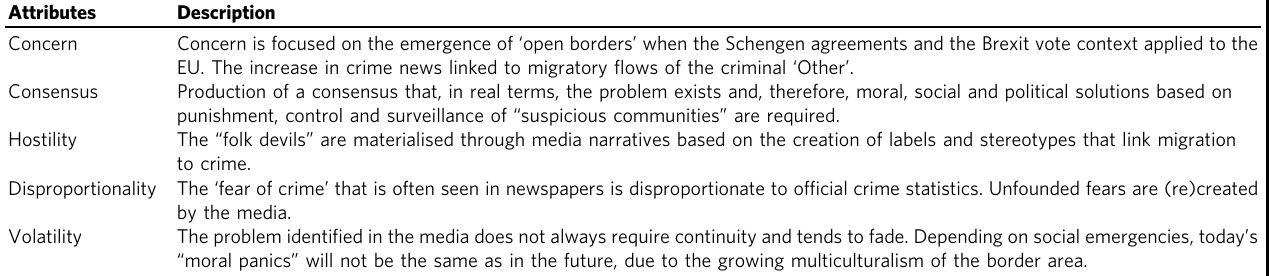
Table 1 Moral panic model